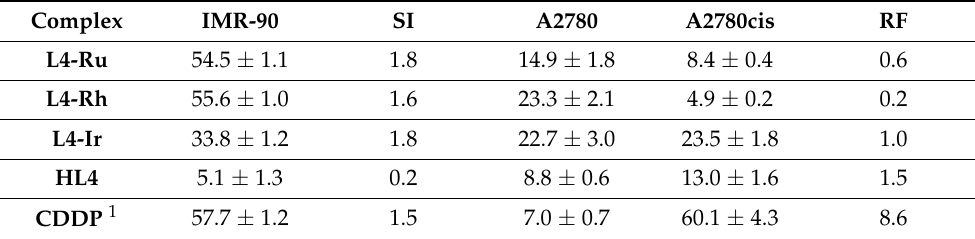
Table 2. IC 50 values expressed in µ M after an exposition period of 24 h for HL4 and L4 complexes, in healthy human lung fibroblasts (IMR-90) and ovarian cancer cells (A2780) sensitive and resistant to cisplatin (A2780cis). Calculated selectivity index (SI = IC 50 (IMR-90)/IC 50 (A549)) and